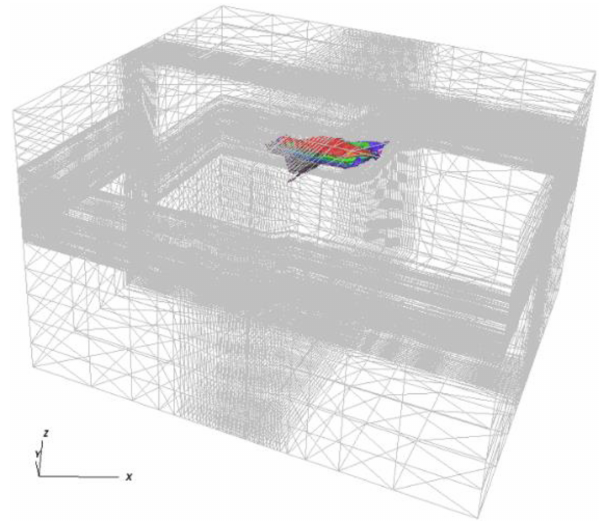
Figure 1. Axonometric view of the 3-D FE grid of the geomechan- ical model. The reservoir is embedded within the grid with different colors distinguishing the producing layers. The vertical exaggera- tion is